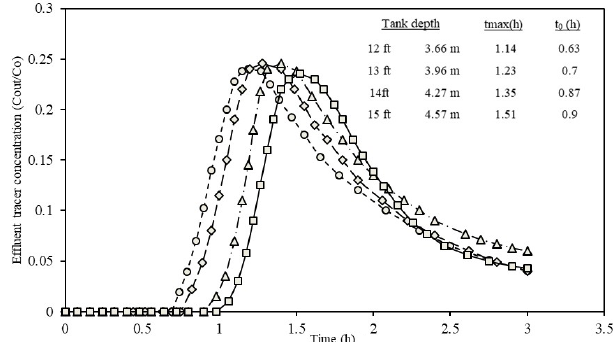
Figure 6. Effluent concentration with a baffle height of 2.13m in tank depth variations.